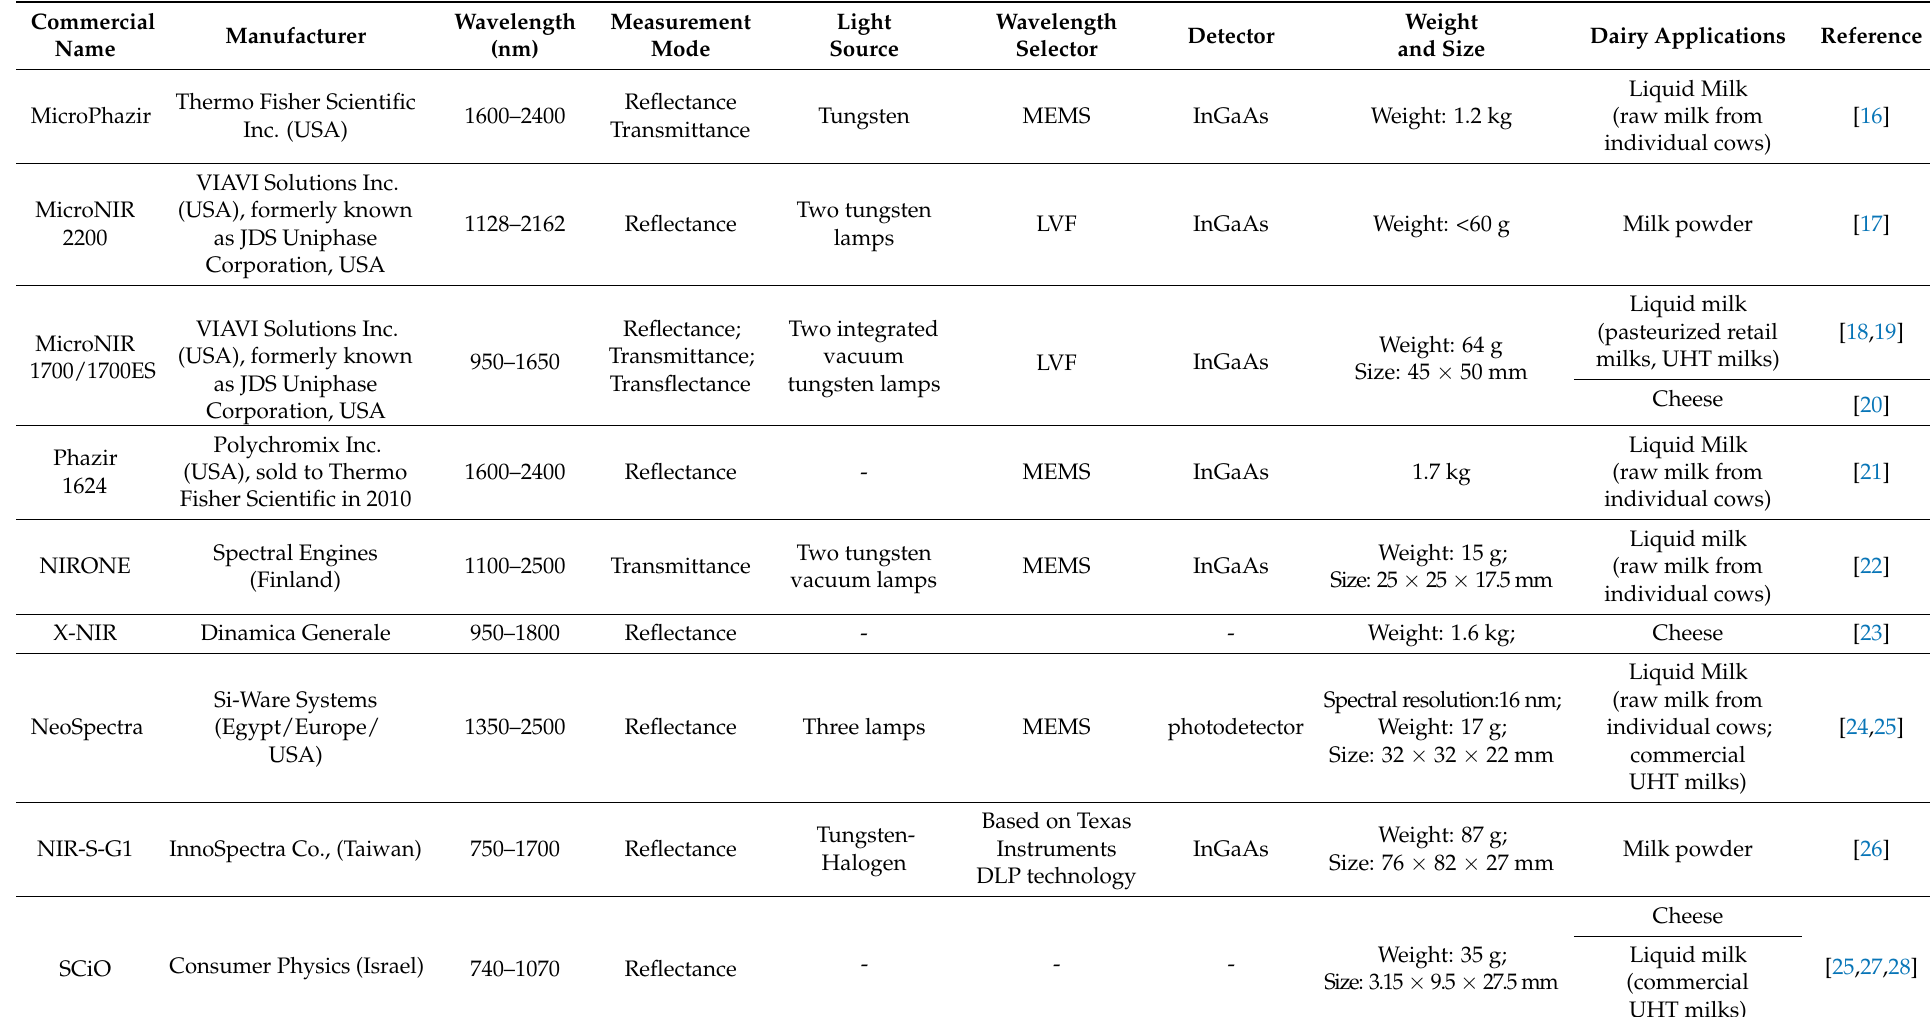
Table 1. Specifications of handheld or portable NIR devices reported in literature with applications in the dairy